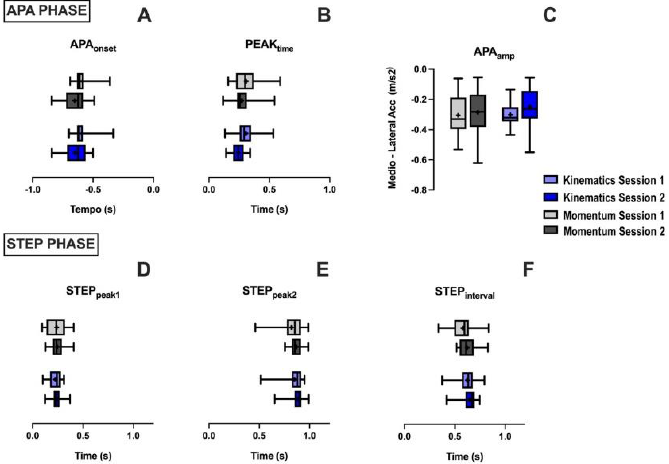
Figure 5. Analysis of mean and SD of subjects in first and second sessions, with both instruments: Kinematics and Momentum app. Top part of graph presents the anticipatory variables, and those below are step variables after heel-off. ( A ): APA onset ; ( B ): PEAK time ; ( C ): APA amp ; ( D ): STEP peak1 ; ( E ): STEP peak2 , and ( F ): STEP interval .